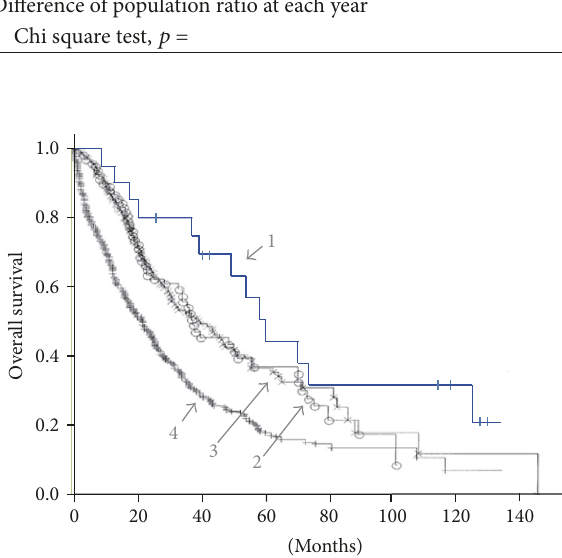
Figure 1: Overall survival (OS) of the present cohort treated comprehensively including AFTV and the historical control cohorts in Japan. Line 1, the present cohort ( 𝑛 = 20 ) with median OS, 60.0 months. Lines 2, 3, and 4, Japanese historical controls taken from Koizumi et al., Figure 2 in [19]. Line 2, patients with solitary sternal metastasis ( 𝑛 = 98 ), median OS, 39.5 months. Line 3, patients with solitary metastatic bone lesion other than sternum ( 𝑛 = 191 ), median OS, 41.4 months. Line 4, patients with multiple metastatic bone lesions ( 𝑛 = 414 ), median OS, 22.6